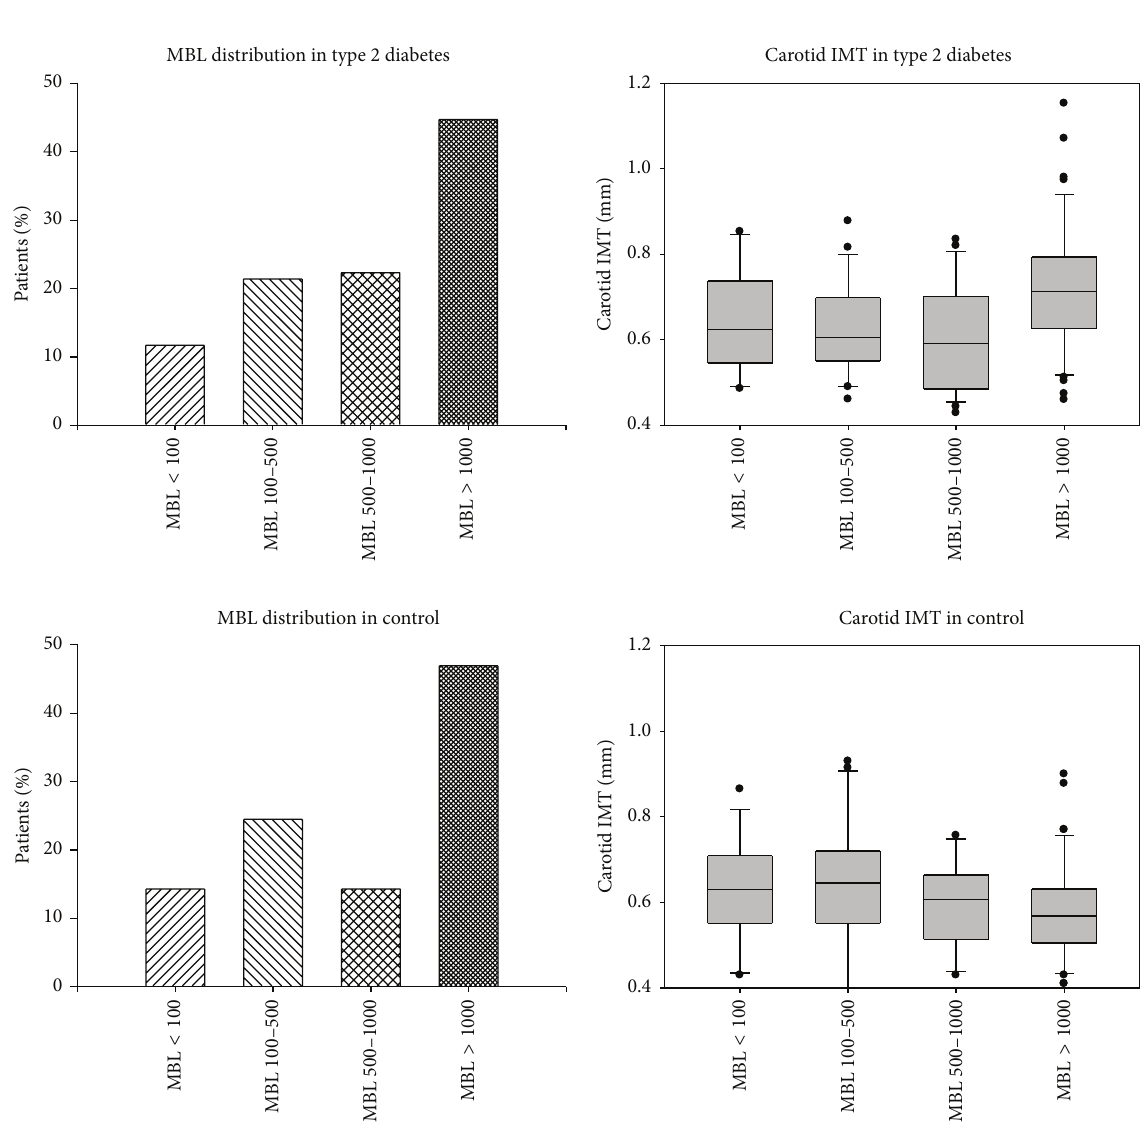
Figure 2: Box and Whisker plots depicting MBL distribution according to various subgroups in type 2 diabetics and control group. Absolute MBL deficiency ( < 100ng/mL), intermediate MBL deficiency (100–500 ng/mL), normal MBL (500–1000 ng/mL), and high MBL levels ( > 1000ng/mL) subgroups are